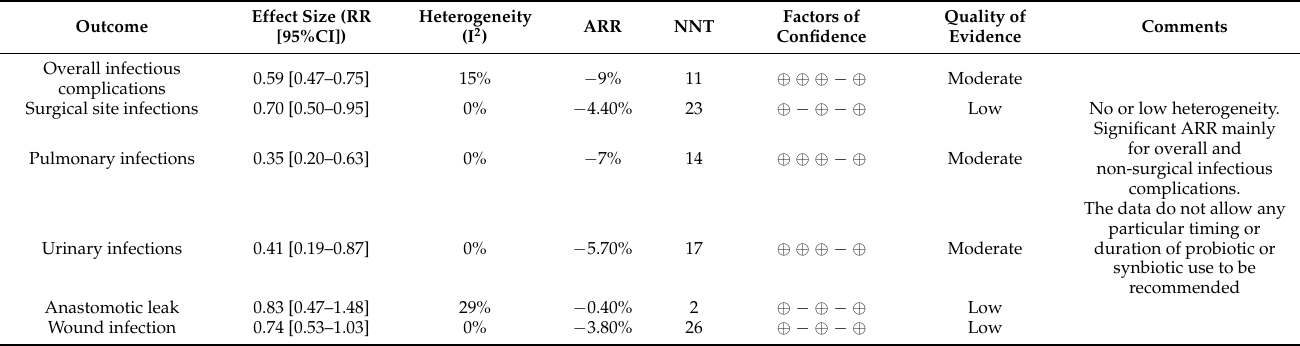
Table 3. Summary of findings: Quality of evidence according to